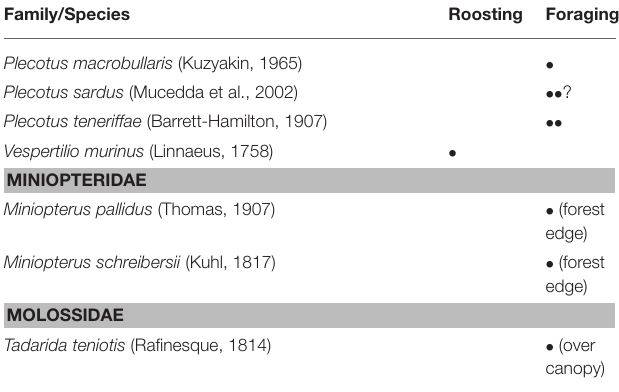
TABLE 1 | List of bat species occurring in the 50 countries of Europe according to